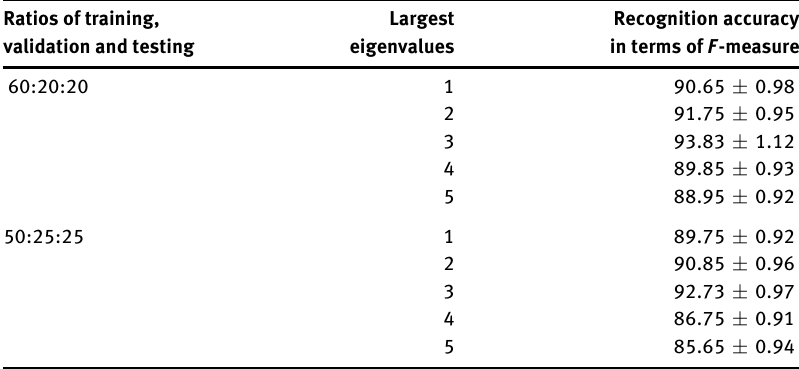
Figure 7: Few Confusing Pairs Such as (A) Devanagari Zero and Devanagari One (More or Less Same Graph Representation) and (B) Devanagari Three and Devanagari Six (Just Mirror Images of Each Other). Table 4: Empirical Evaluation of ‘ n ’ Largest Eigenvalues. Ratios of